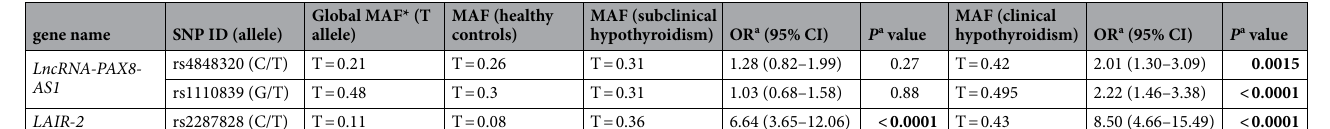
Table 2. Basic information of studied single nucleotide polymorphisms and odds ratio estimates for subclinical and clinical hypothyroidism. MAF minor allele frequency. *According to Ensembl release 102— November 2020. OR odds ratio, CI confidence interval. a Adjusted for age and sex in a logistic regression model using SNPstats online software. P values in bold means statistical significance from healthy controls ( P <